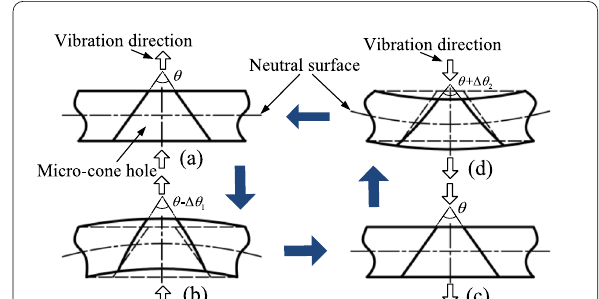
Figure 4 The schematic diagram of deformation process of micro-cone hole in a cycle